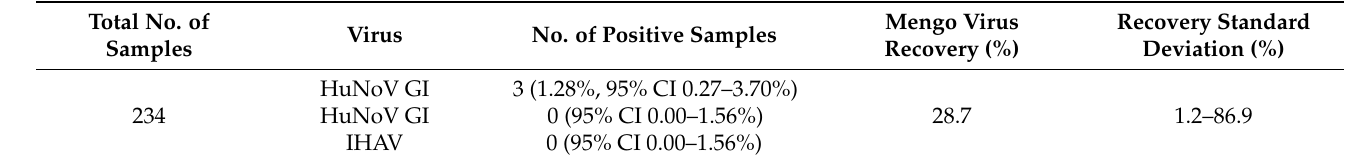
Table 3. Summary of HuNoV GI, HuNoV GII and HAV detection in RTE cranberries harvested in